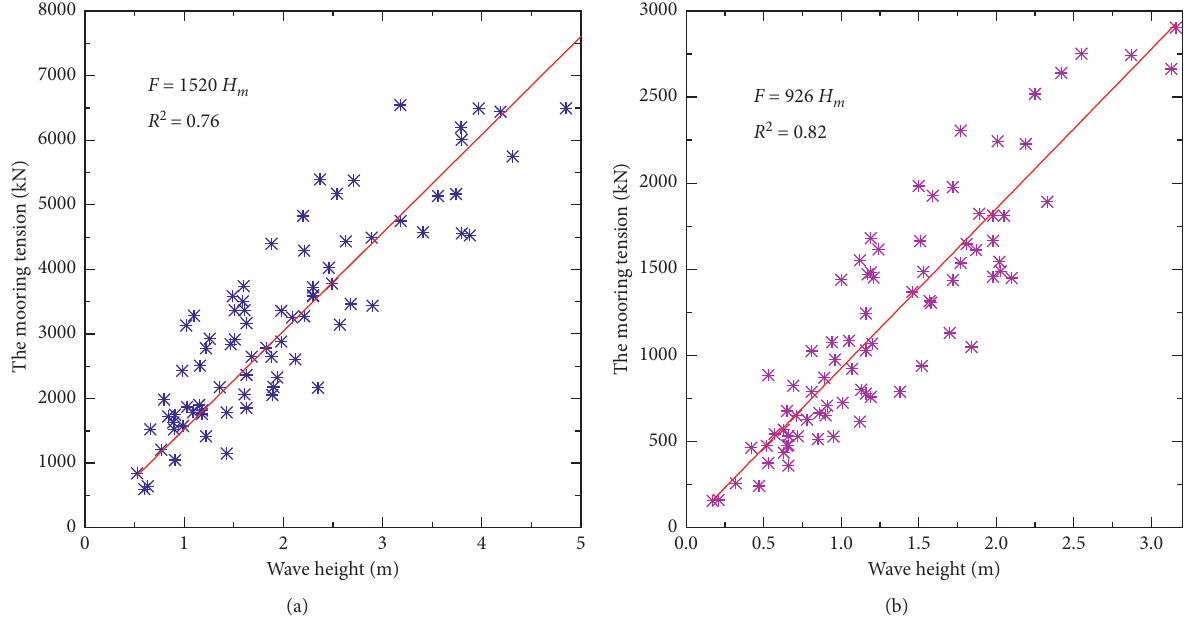
Figure 15: The relationship between mooring tension and wave height: (a) in convex bank and (b) in concave